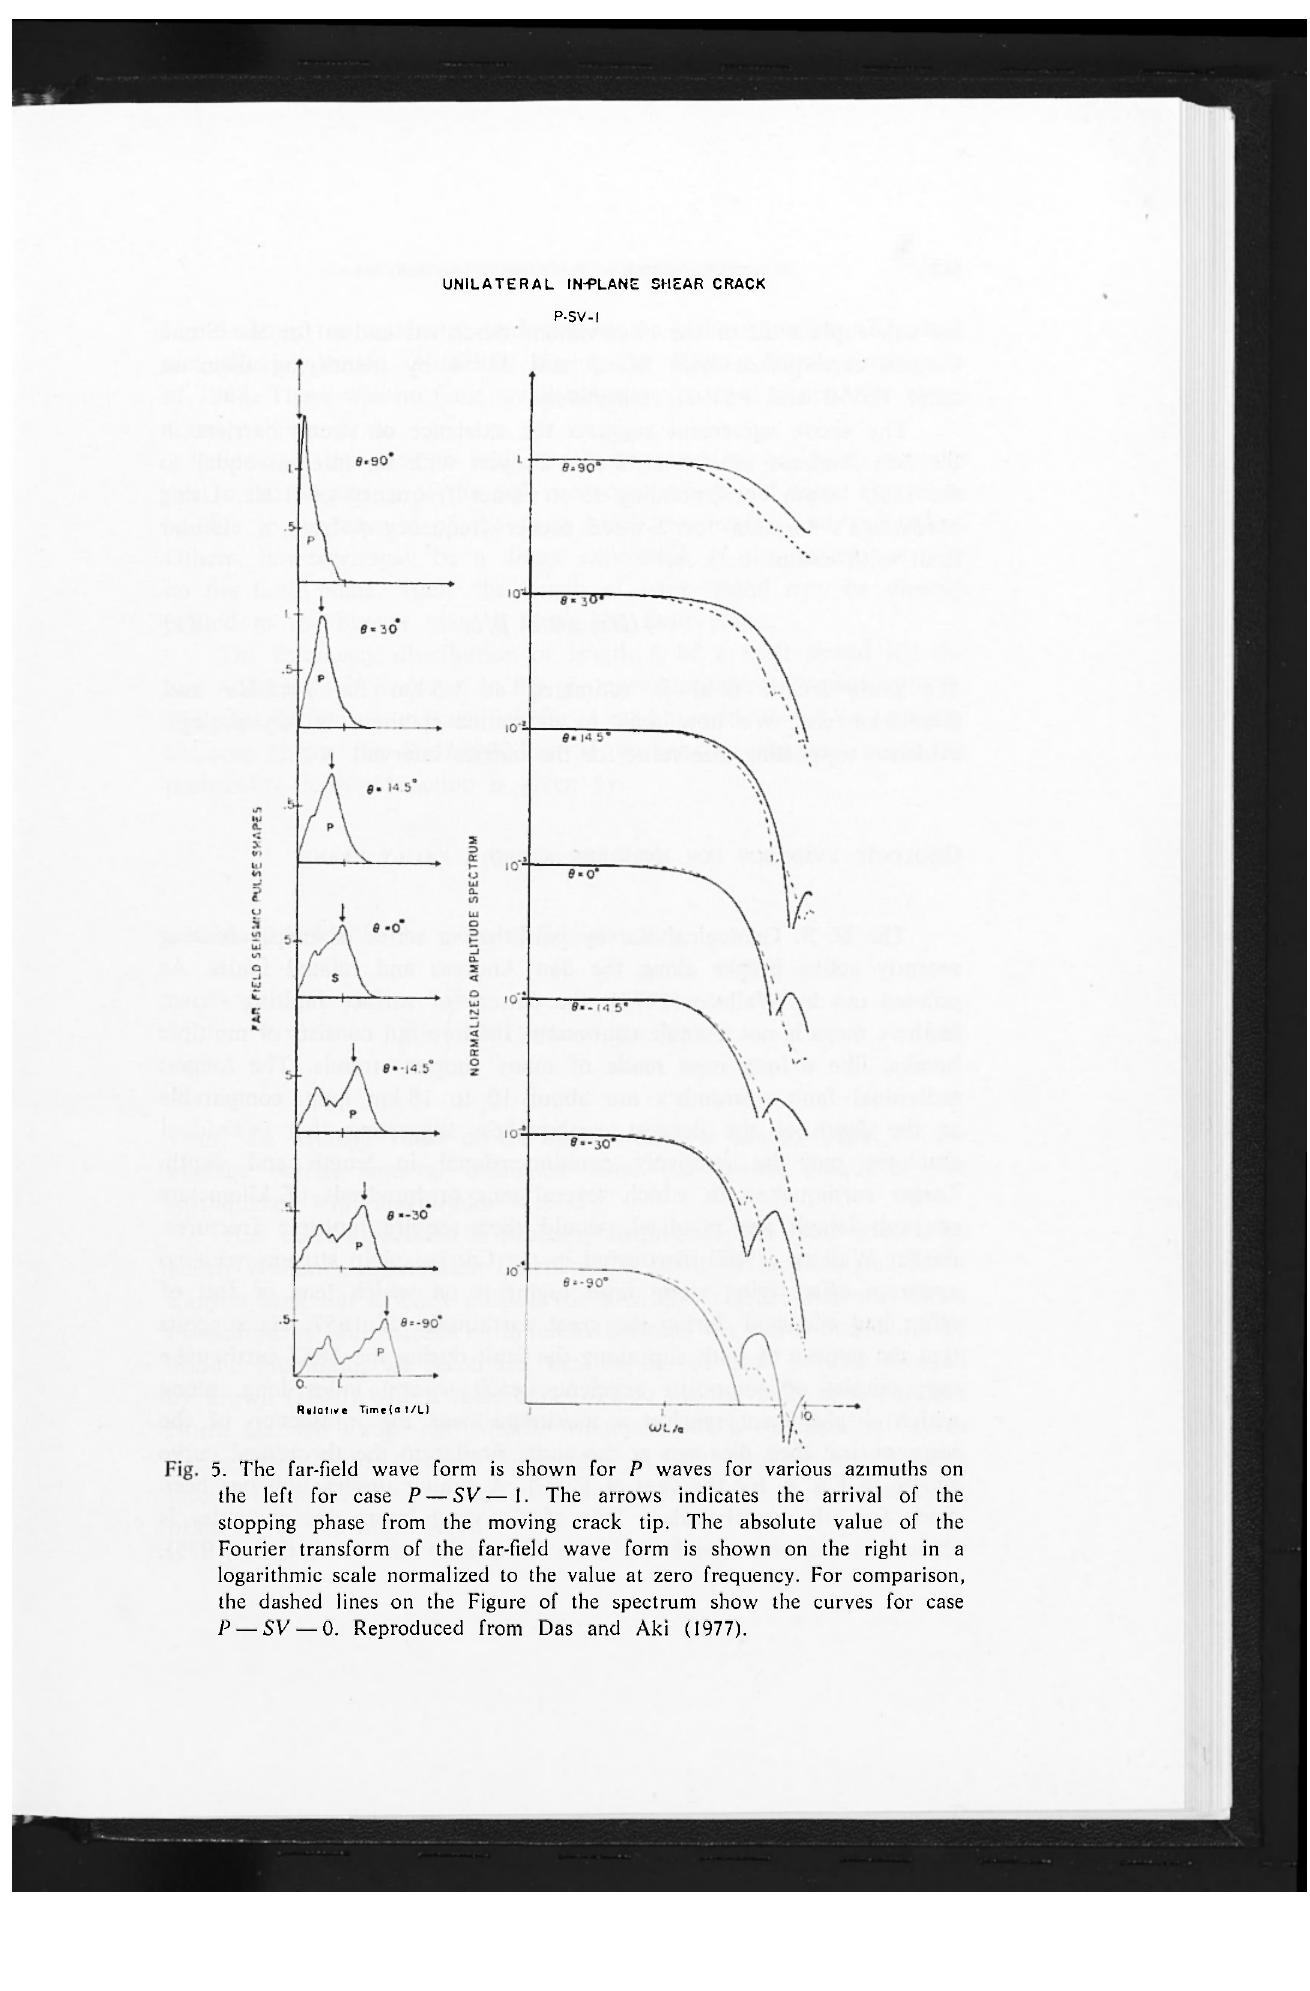
5. The far-field wave form is shown for P waves for various azimuths on the left for case P — SV • —1. The arrows indicates the arrival of the stopping phase from the moving crack tip. The absolute value of the Fourier transform of the far-field wave form is shown on the right in a logarithmic scale normalized to the value at zero frequency. For comparison, the dashed lines on the Figure of the spectrum show the curves for case P — SV — O. Reproduced from Das and Aki